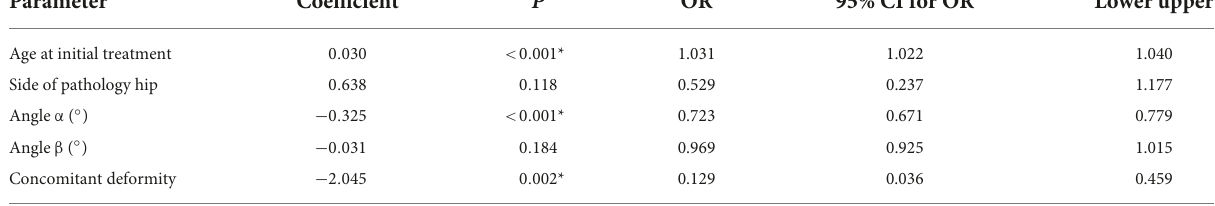
TABLE 3 Multivariate logistic regression analysis.